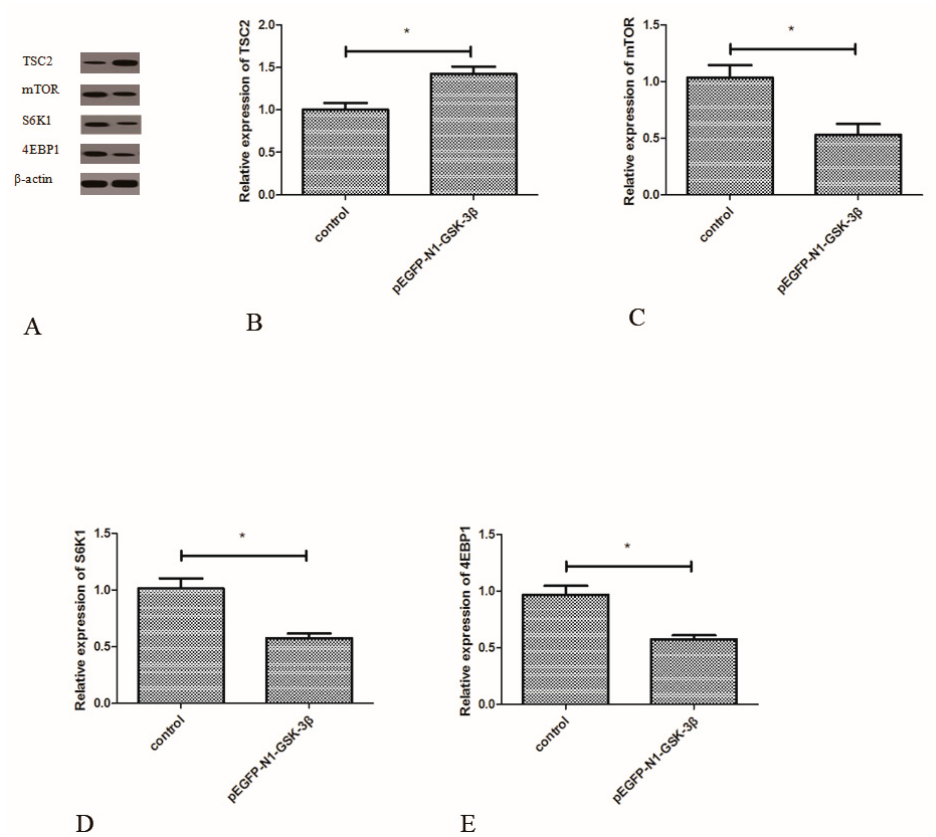
Figure 7. Effect of the pEGFP-N1-GSK-3 β vector on the protein expression of TSC2, mTOR, S6K1, and 4EBP1 in the muscle of zebrafish. ( A ) The protein bands; ( B ) TSC2; ( C ) mTOR; ( D ) S6K1; ( E ) 4EBP1. Values are expressed as means ± s.e.m. ( n = 6). Statistically significant differences are denoted by an asterisk ( p < 0.05).